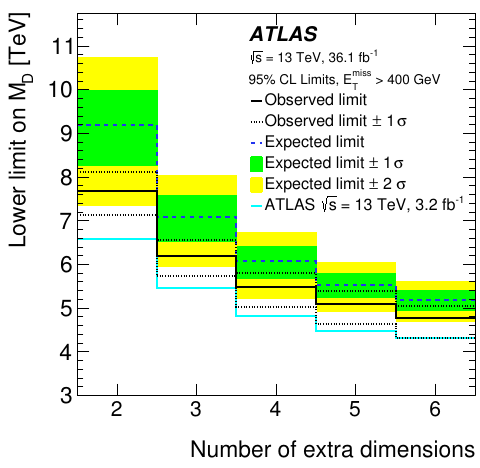
Figure 11 . Observed and expected 95% CL lower limits on the fundamental Planck scale in 4 + n dimensions, M D , as a function of the number of extra dimensions. The bands indicate